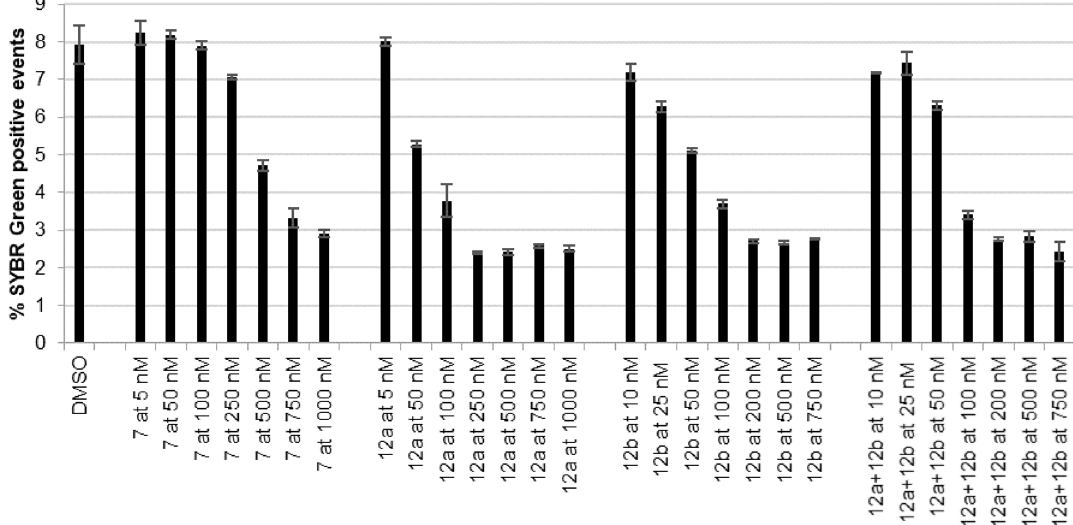
Figure 12. Inhibition of P. falciparum in the presence of different concentrations of 12a + 12b mixture, 12a , 12b, and 7 . A ring stage synchronized culture of P. falciparum ( Pf NF54) was incubated for 48 h with increasing concentrations of the compounds, DMSO (vehicle control). The percentage of SYBR Green positive events per concentration is represented. DMSO is represented as a negative control. Each time point represents the mean value of triplicate measurements (± one SD), n =